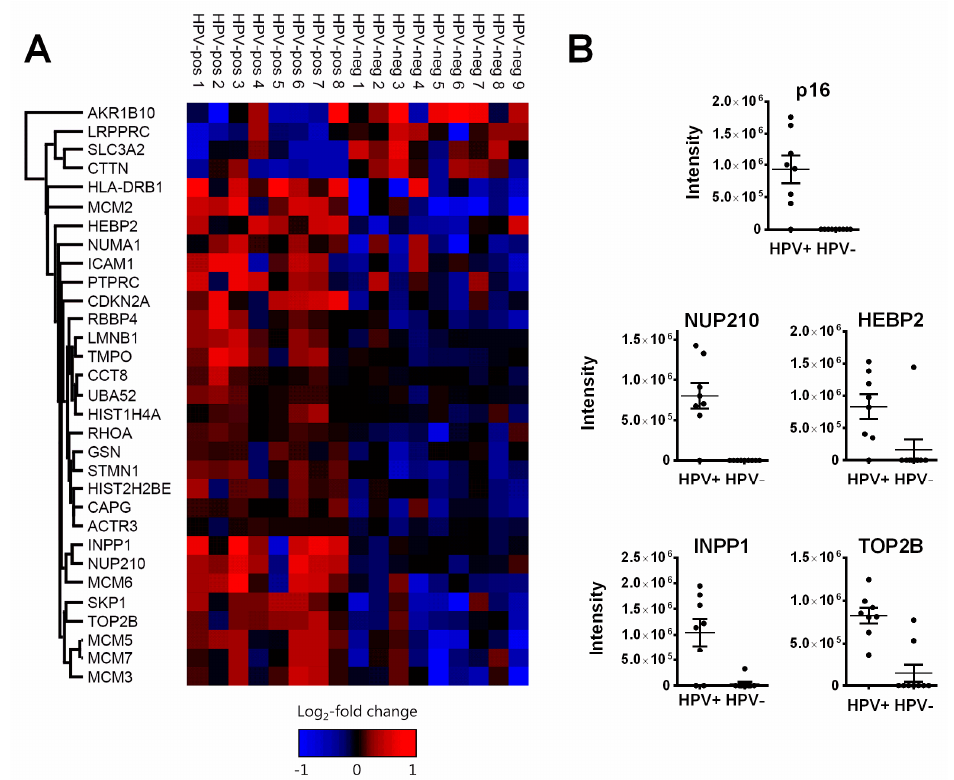
Figure 2. Proteins di ff erentially expressed in HPV-positive and HPV-negative OPSCC. ( A ) Heat map depicting the di ff erentially expressed proteins. Only four proteins were found to be expressed at a higher level in HPV-negative OPSCC. ( B ) Expression levels of proteins (almost) exclusively detected in HPV-positive OPSCC as assessed by LC–MS / MS intensity values. Note that for ( A ) and in the statistical analyses, random low-intensity values were assigned to proteins not detected in the LC–MS / MS measurement to avoid false-positive significance. Table 2. Proteins differentially expressed in HPV-positive and HPV-negative HNSCC. Proteins 1-24 were identified as unequally expressed through the random forest analysis, proteins 25-31 were additionally identified through significance (unadjusted) and fold change (difference ≥ 2 fold, corresponding to Log2FC values ≥ 1 or ≤− 1) congruently in this and a comparable previous study [29]. Bold numbers indicate that the respective thresholds were met.